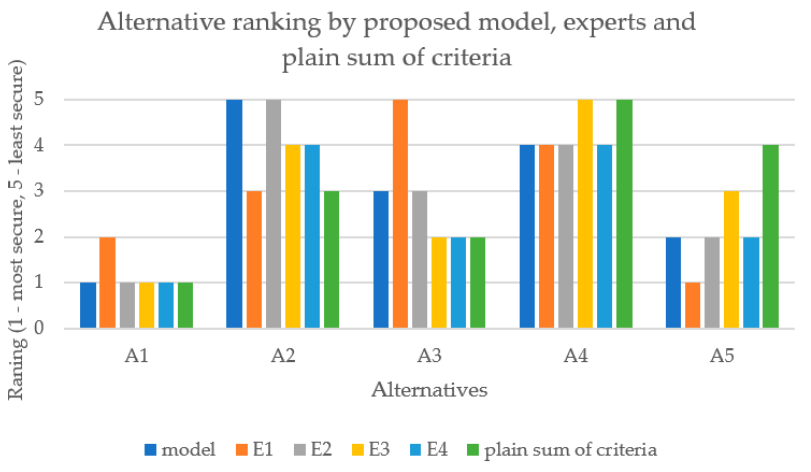
Figure 6. Security level ranking for each alternative, evaluate by the proposed model, experts, and plain sum of criteria.